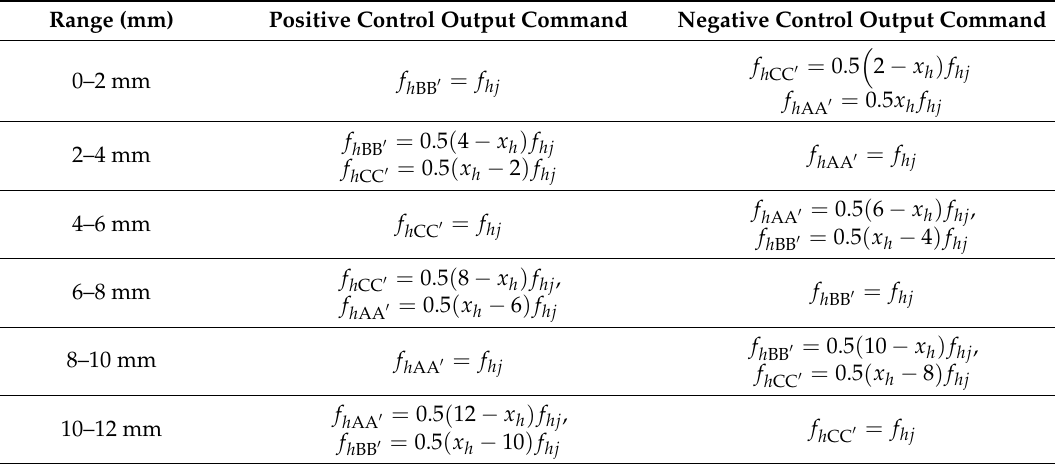
Table 2. Multi-phase excitation scheme for each mover.